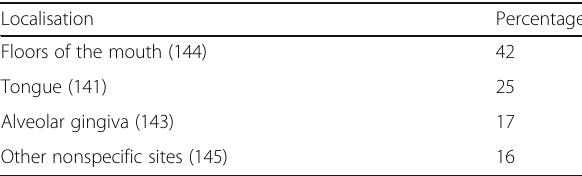
Table 2 Tumour localization (number of patients